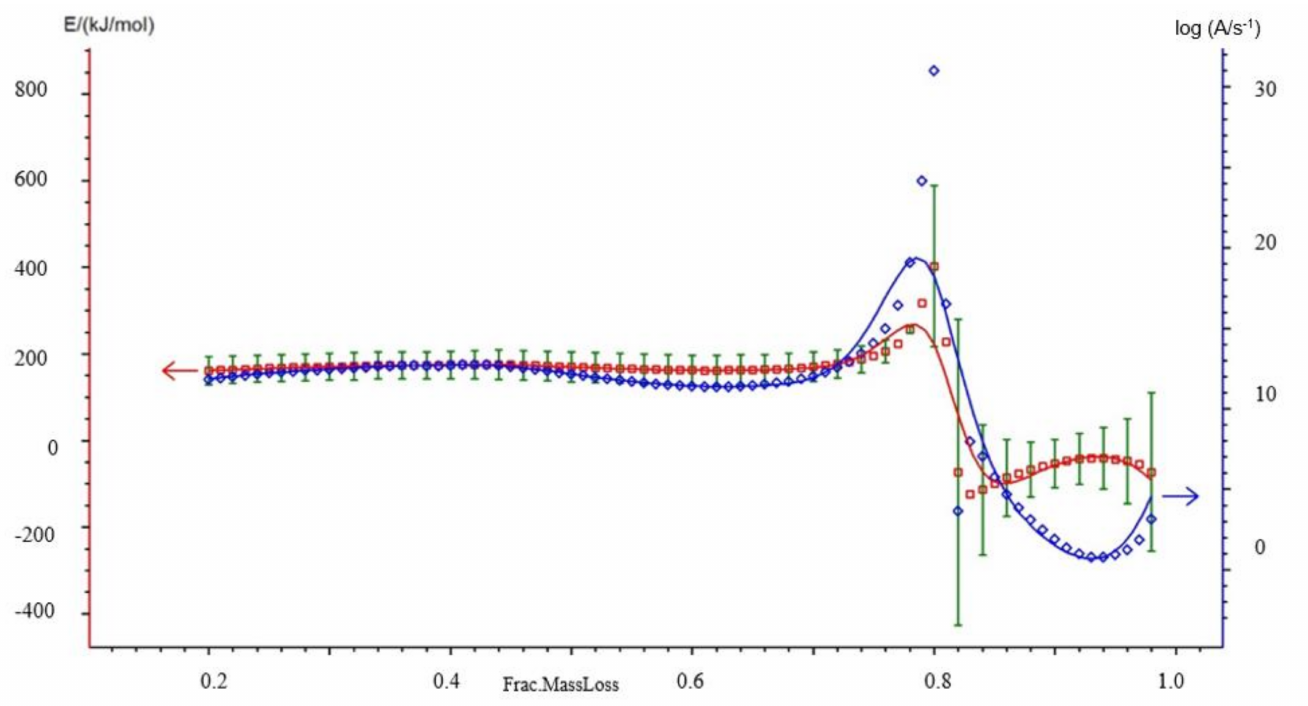
Figure 13. Activation energy (Red color) and pre-exponential coefficient (Blue color) as a function of the degree of conversion determined by the Ozawa—Flynn–Wall method for pine wood. Green color represents the statistical